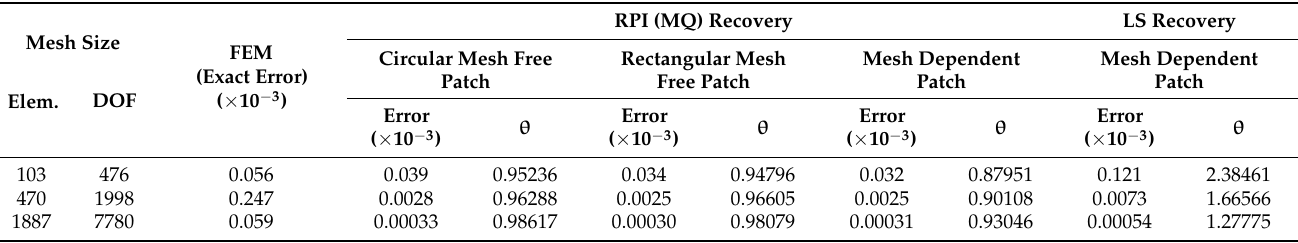
Table 8. Error convergence and global effectivity ( θ ) obtained for RPI (MQ) and least square based displacement recovery techniques (quadratic triangular, L 2 norm).